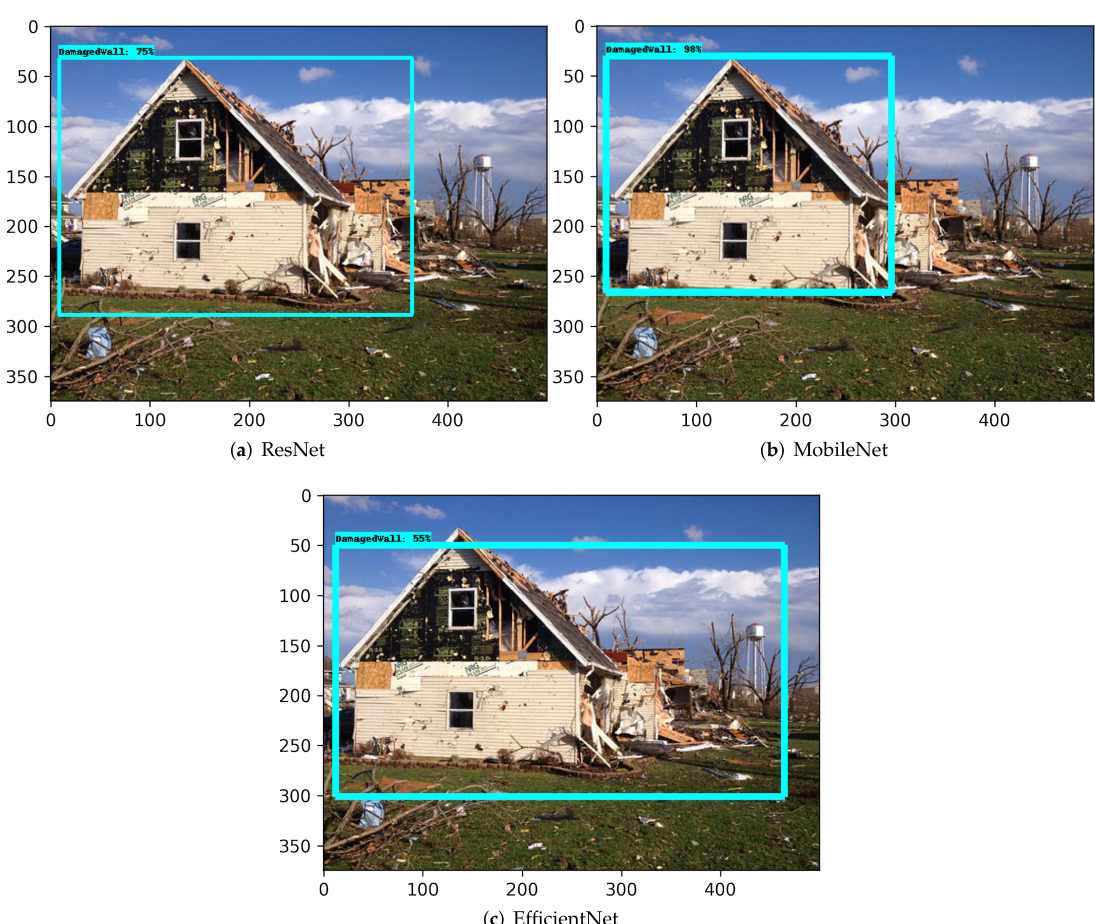
Figure 7. Inference carried out on the image of a damaged wall for each of the three models. The blue bounding boxes correspond to the correct prediction of a damaged wall from the first row of Table 5.